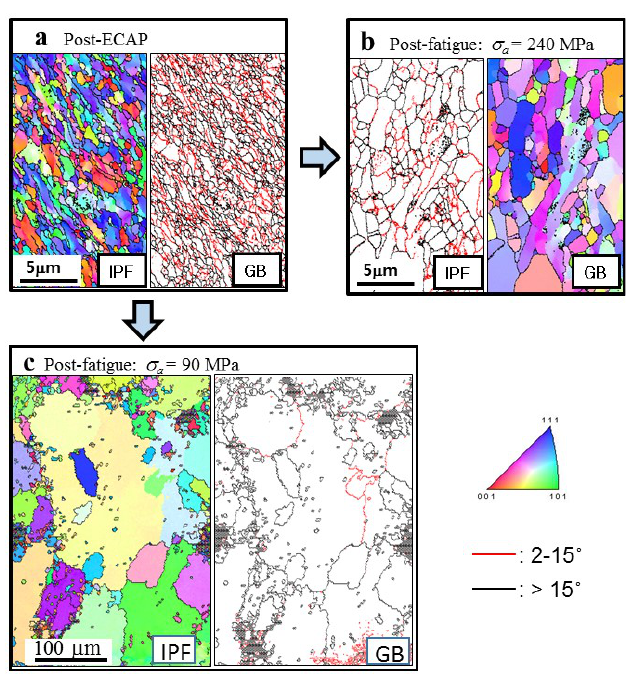
Figure 8: Orientation Imaging Microscopy orientation for sub-surface microstructure in the zx -plane: (a) original microstructure before stressing; (b) after constant stressing at  a = 240 MPa; (c) after constant stressing at  a = 90 MPa F ( α ) = K ( α )/ K ( α ) i i i E